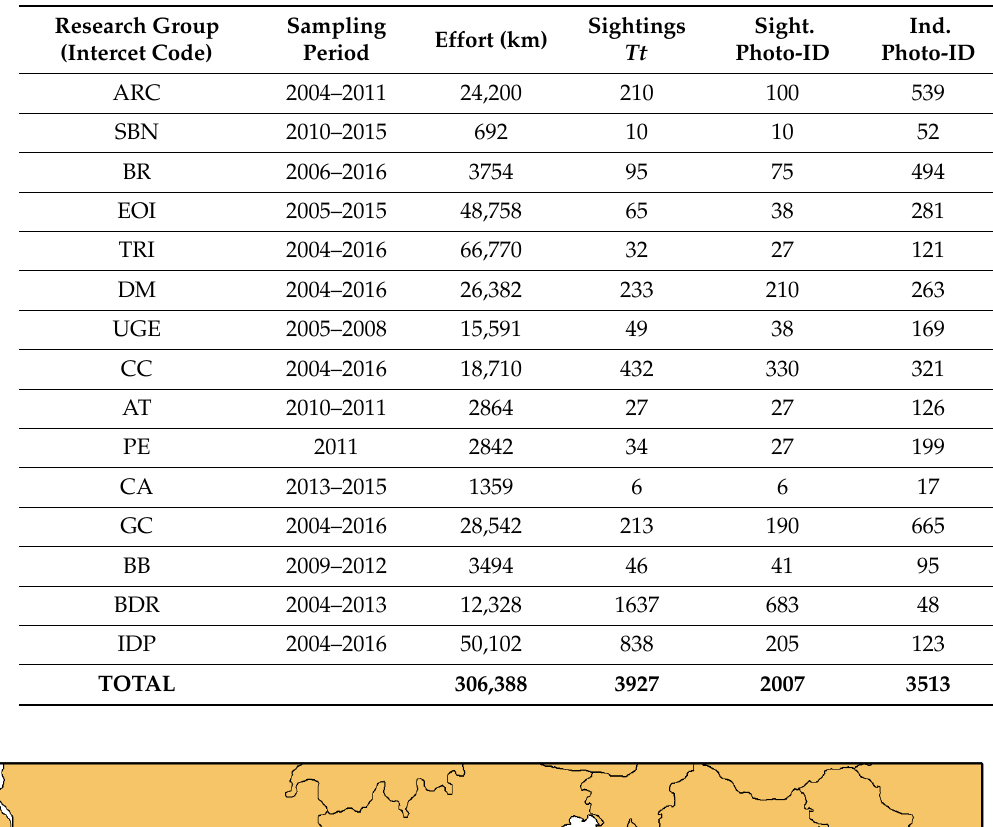
Table 2. The sampling effort implemented by each research group (Effort (km), the resulting sightings of bottlenose dolphins (Sightings Tt ), the sightings during which photographic data for photo- identification of the individuals were collected (Sight. Photo-ID) and the total of individuals photo- identified (Ind. Photo-ID).